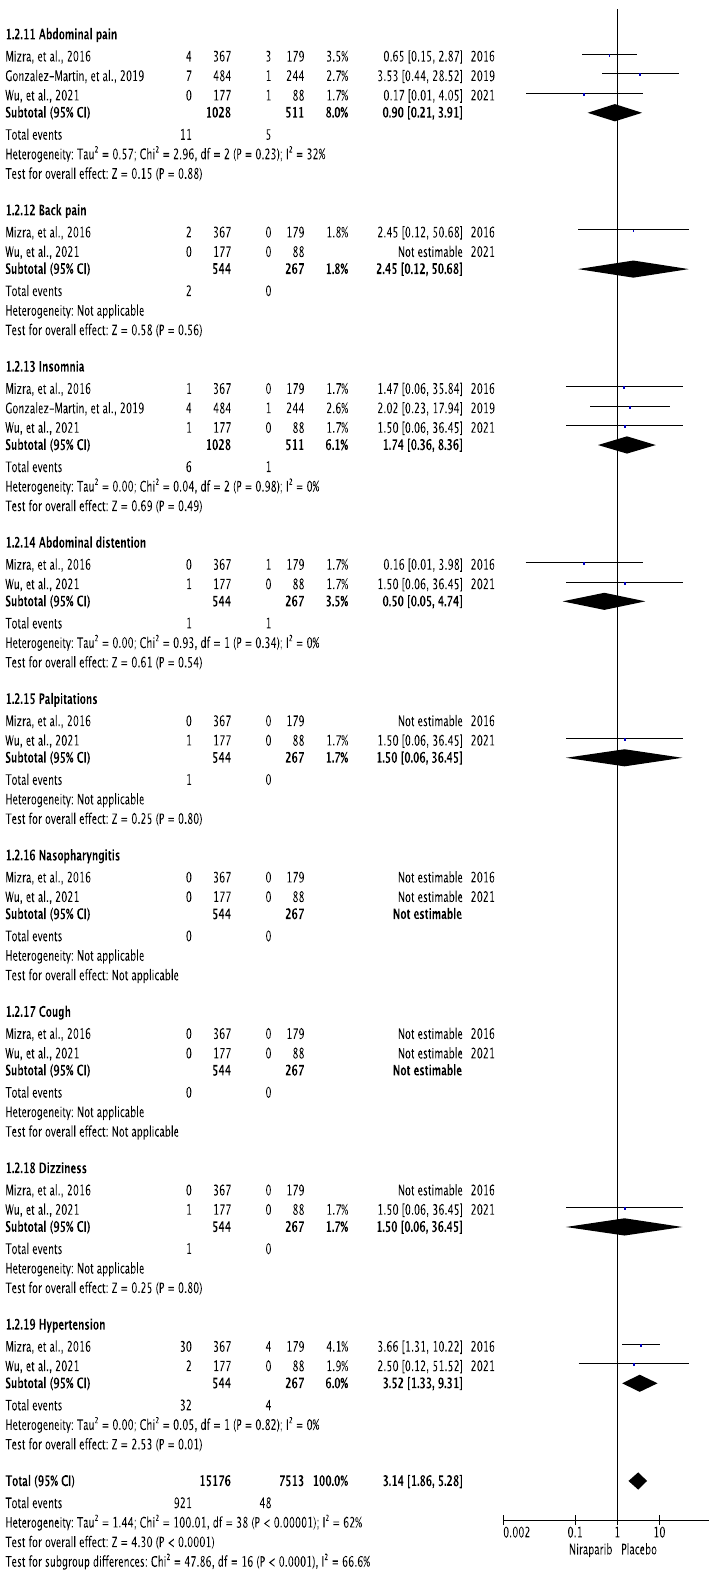
Figure 3. Forest plot of the meta-analysis of grade 3 or 4 adverse effects in NOVA, PRIMA and NORA studies.